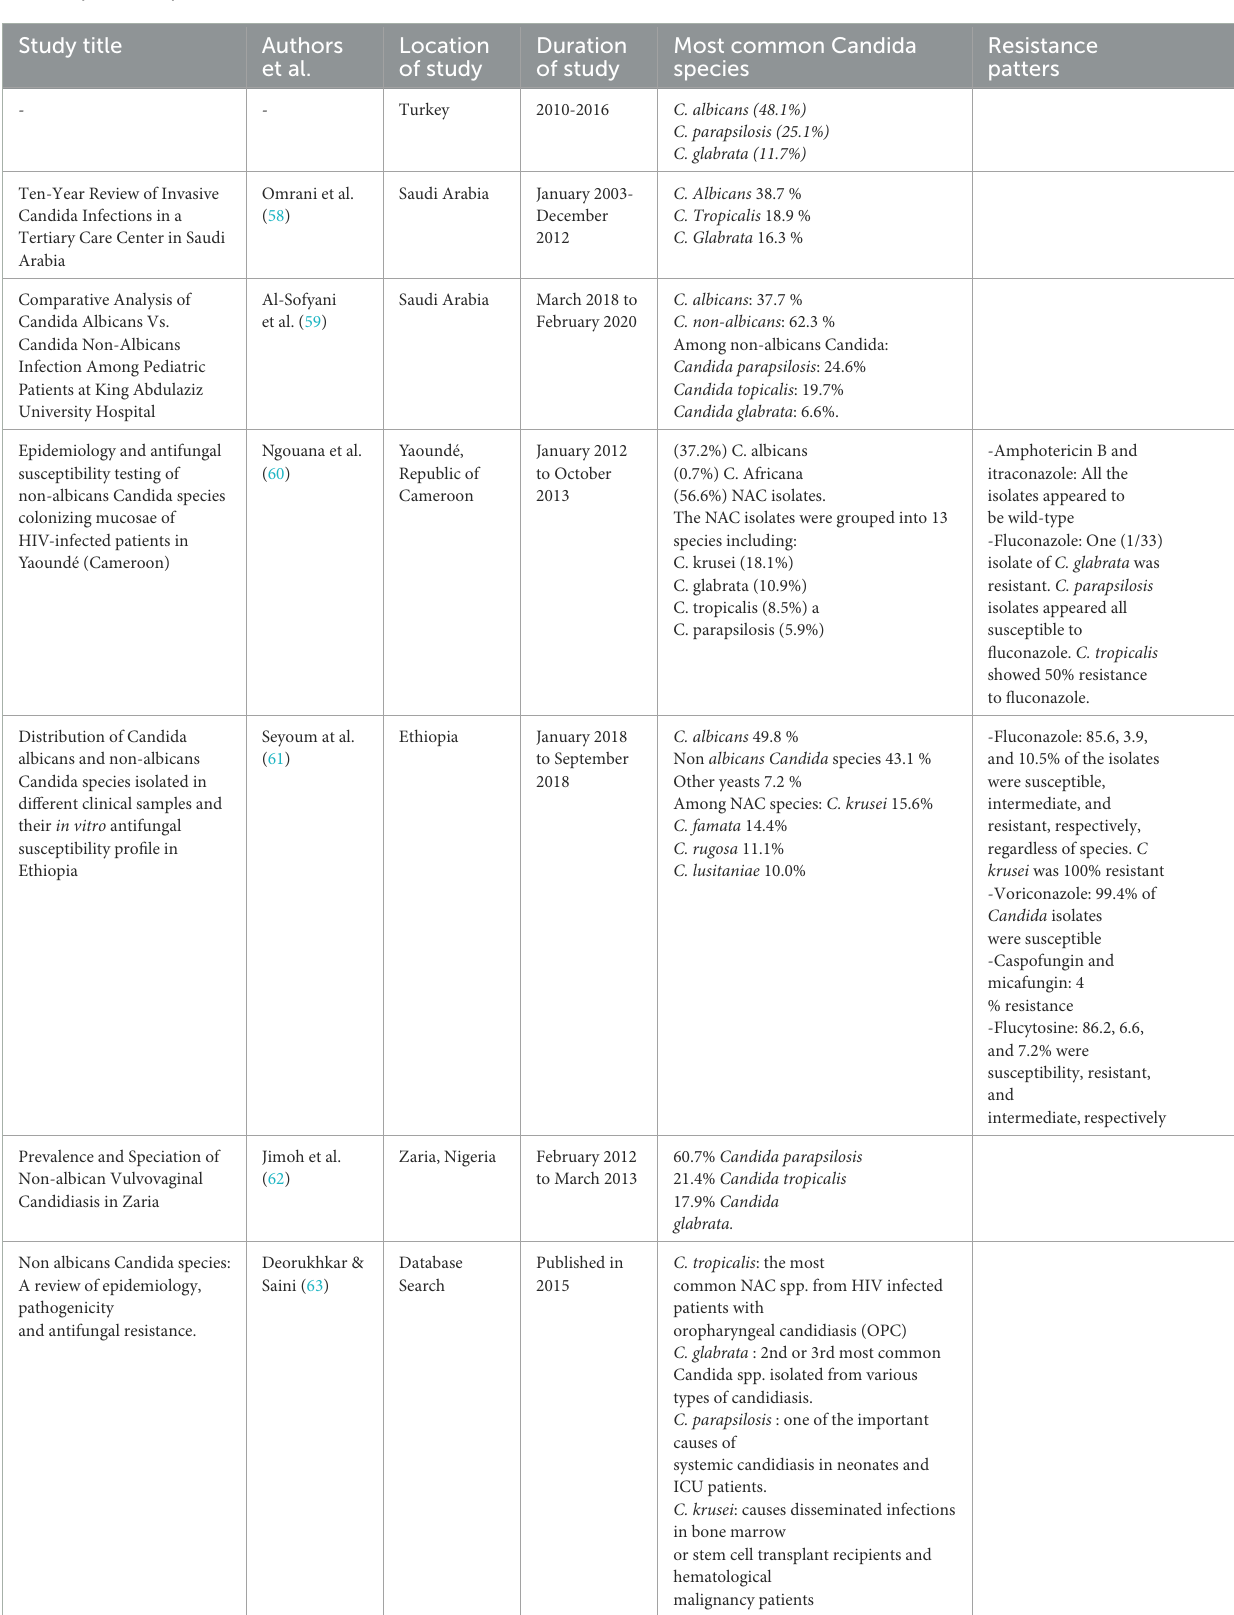
C. tropicalis : the most common NAC spp. from HIV infected patients with oropharyngeal candidiasis (OPC) C. glabrata : 2nd or 3rd most common Candida spp. isolated from various types of candidiasis. C. parapsilosis : one of the important causes of systemic candidiasis in neonates and ICU patients. C. krusei : causes disseminated